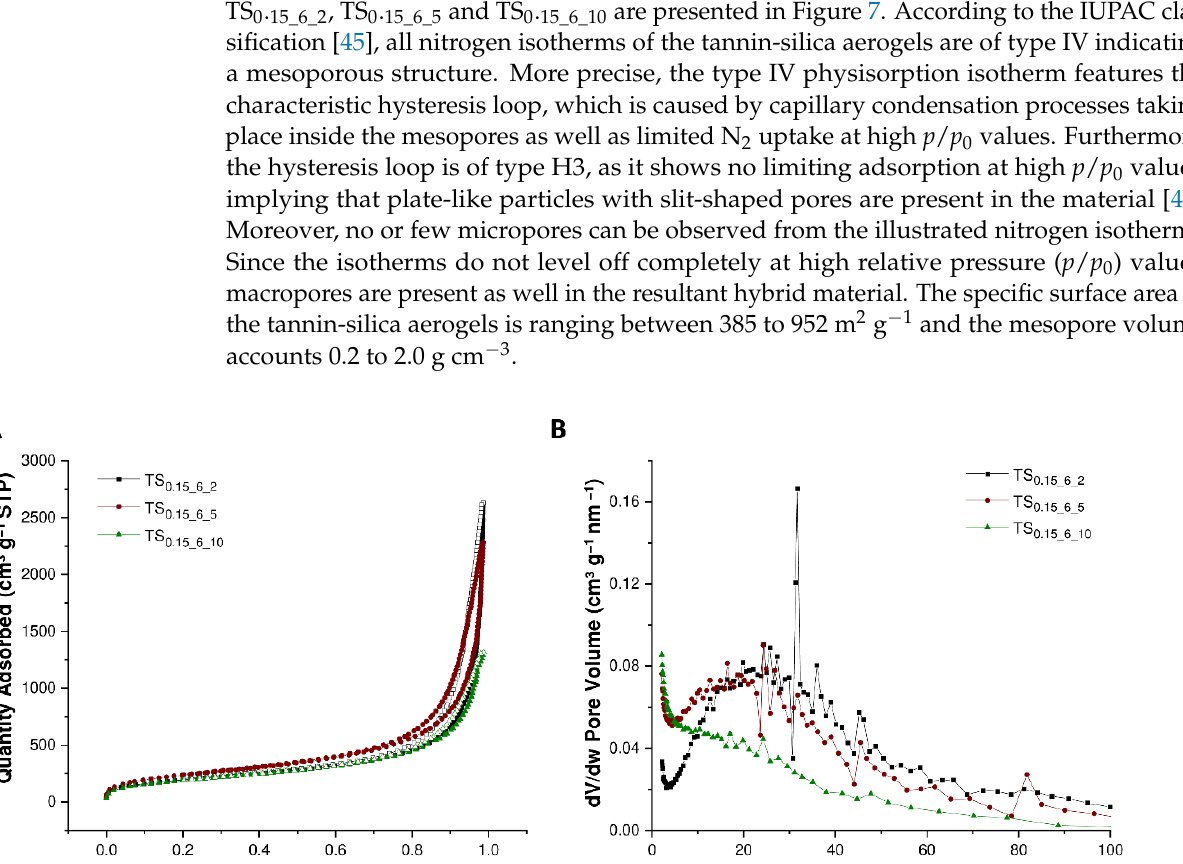
Table 1. Determined shrinkage percentage, porosity, bulk density, skeletal density values, mesopore volume (* up to 40 nm) and specific surface area of the prepared tannin-silica aerogels using a crosslinker.